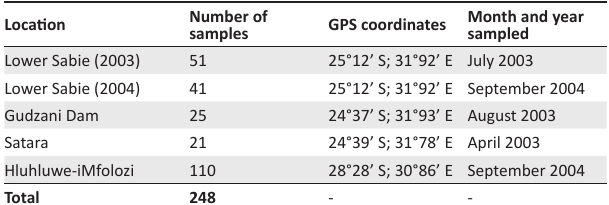
TABLE 1: Information on the buffalo sera used in this study.